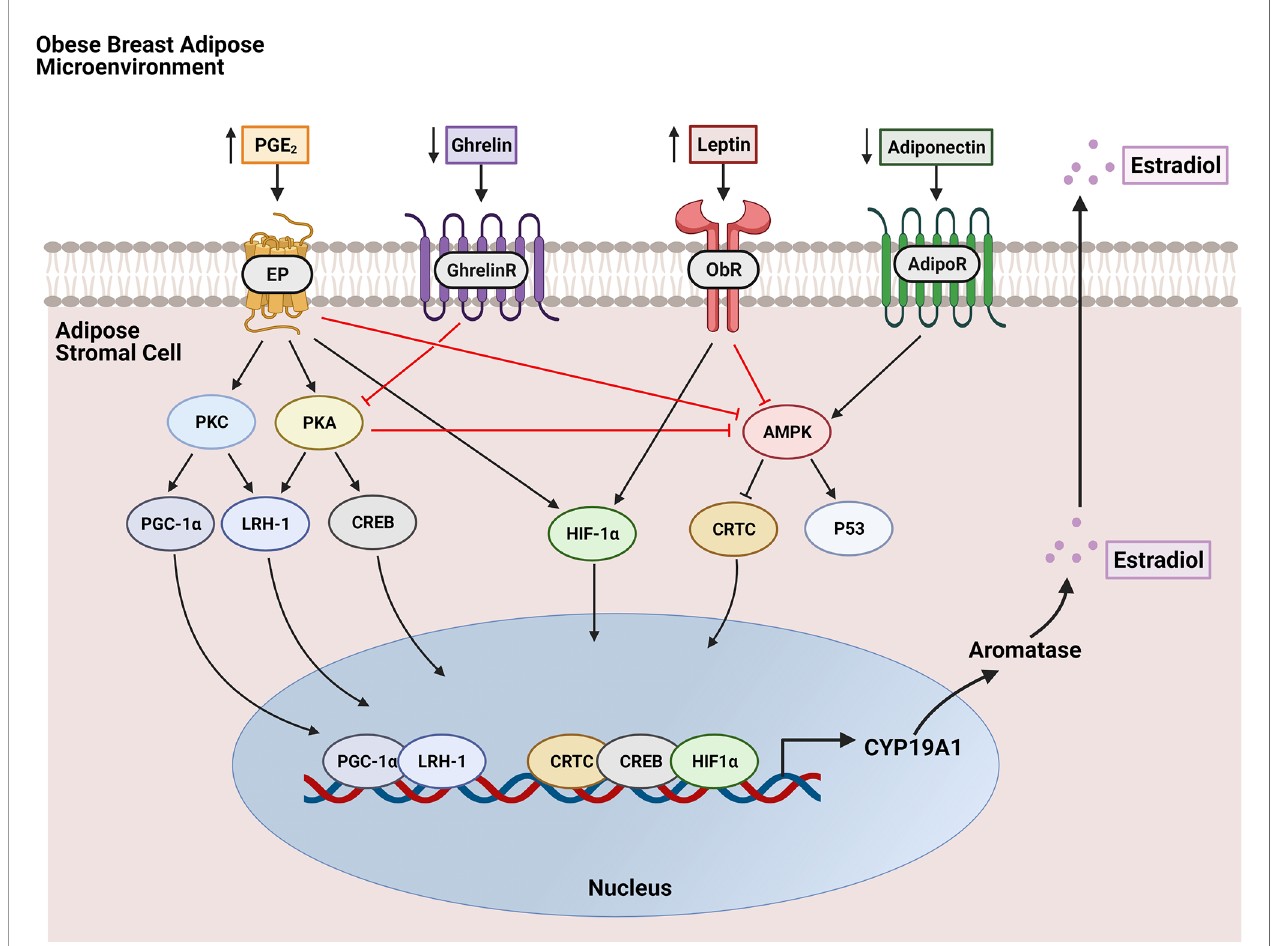
FIGURE 2 | Regulation of aromatase expression in breast adipose stromal cells by the obese breast microenvironment. Hallmarks of the obese breast microenvironment include elevated PGE 2 and leptin along with decreases in ghrelin and adiponectin. PGE 2 binds EP receptors to activate signaling through protein kinase C (PKC) and protein kinase A (PKA) which results in increased expression and nuclear localization of transcription factor co-activator PGC-1 a and transcription factors LRH-1 and CREB which both drive aromatase (CYP19A1) transcription. PGE 2 also enhances aromatase expression through stimulation of HIF- 1 a -driven aromatase transcription and through inhibition of AMPK. AMPK activation negatively regulates aromatase by inhibiting entry into the nucleus of the aromatase transcription factor CRTC and by stimulating P53, which has been shown to translocate to the nucleus and inhibit aromatase transcription. Leptin signaling through its receptor ObR also increases HIF-1 a expression and nuclear localization while inhibiting AMPK signaling. Both ghrelin and adiponectin negatively regulate aromatase expression through inhibition of PKA and through activation of AMPK, respectively. However, these factors are downregulated in the obese breast microenvironment, thereby decreasing their inhibitory effects on aromatase expression. The net effect of increased aromatase expression catalyzes the production of estradiol, which is released into the breast